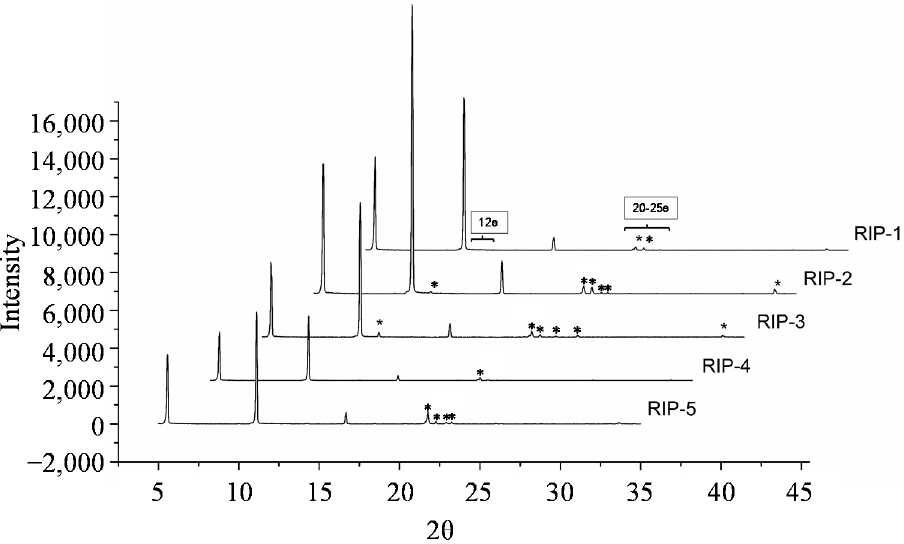
Figure 7. PXRD patterns of riparin I batches. The (*) show characteristic diffraction pattern for each lot.